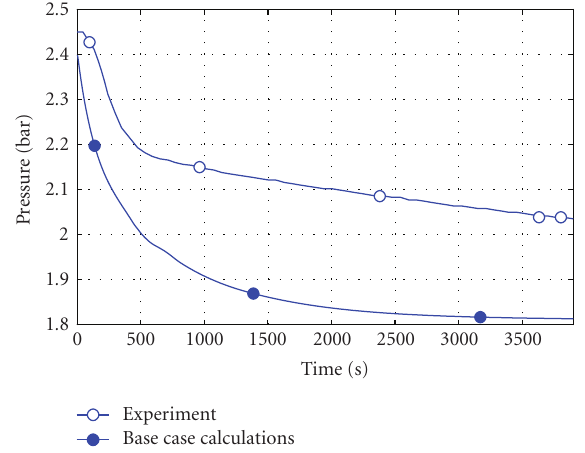
Figure 4: Pressure evolution using homogenous initial conditions.